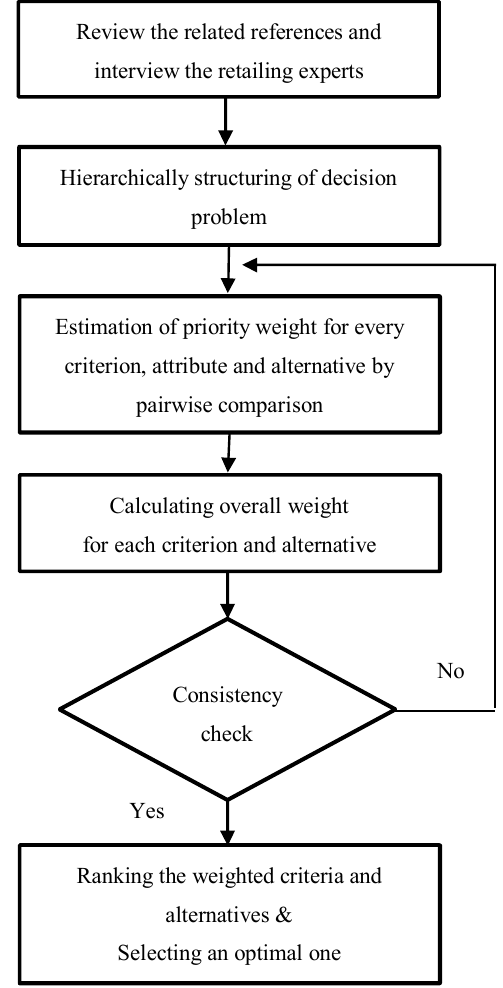
Fig 1. AHP Application